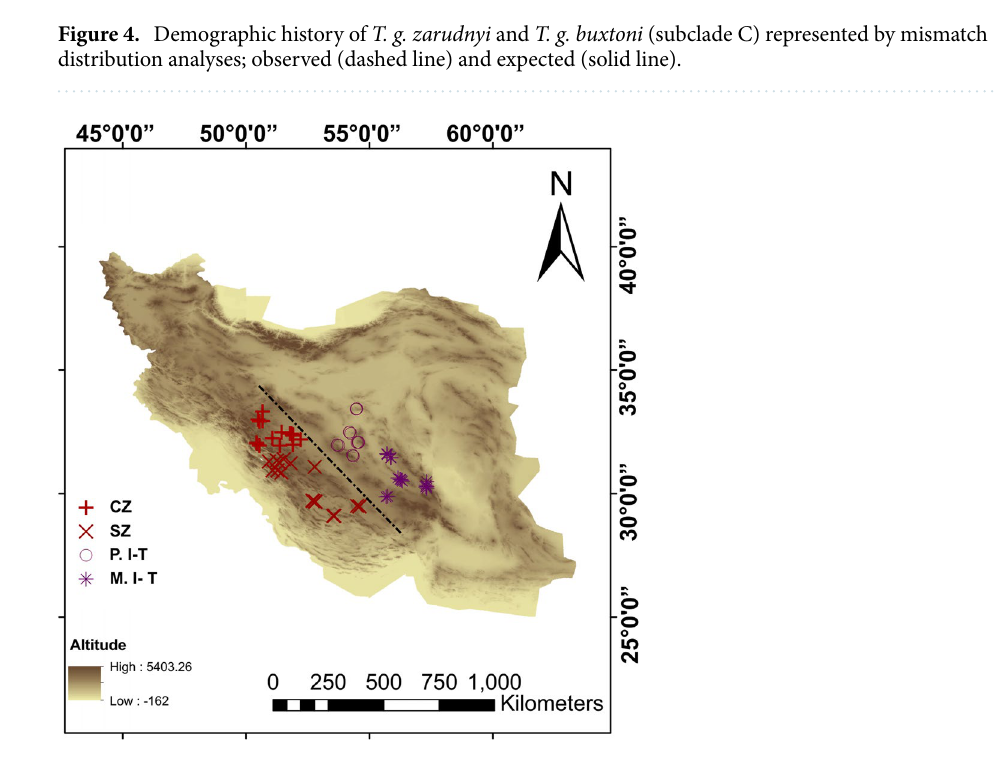
Figure 5. Four morphological clusters of Testudo graeca in the contact zone of T. g. zarudnyi and T. g. buxtoni in the Central Iran. CZ: Central part of Zagros Eco-region, SZ: Southern part of Zagros Eco-region, P. I-T: Plain areas of Irano-Turanian Eco-region and M. I-T: Mountainous areas of Irano-Turanian Eco-region. The base map was obtained from OpenStreetMap contributors, available under Open Data Commons Open Database License (www. opens treet map. org/ copyr ight) and developed in ArcGIS